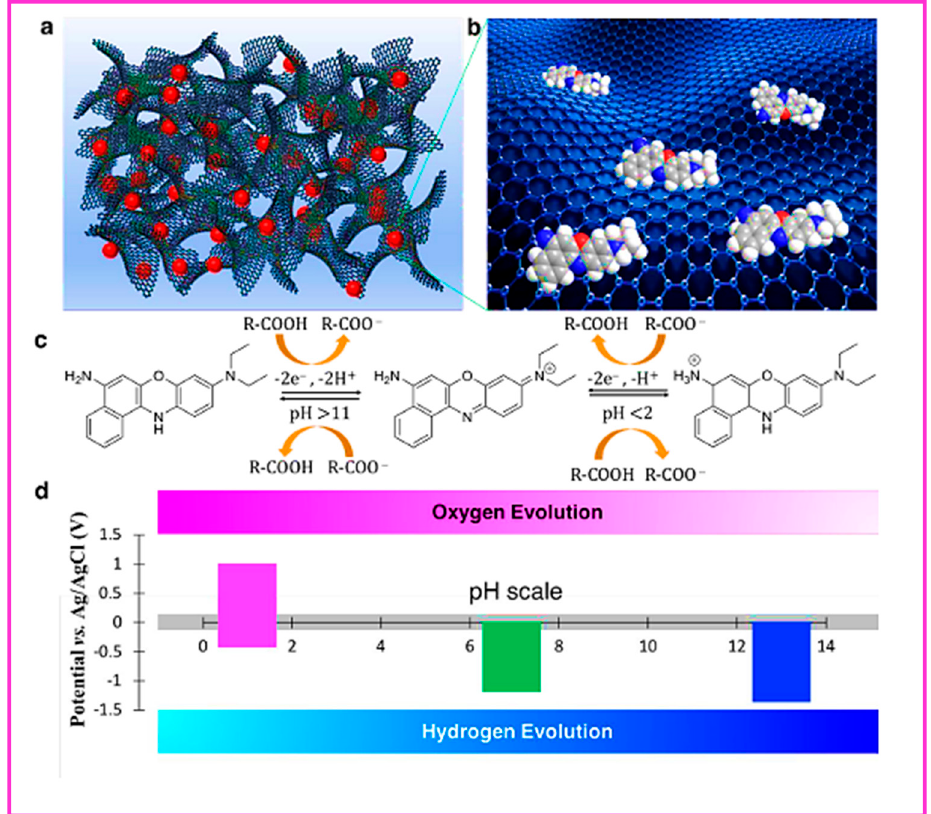
Figure 10. Illustration of the physically-chemically conjugation of Nile Blue. ( a ) The 3D porous structure of graphene aerogel ( b ), The possible faradic reactions of Nile Blue in strongly acidic and alkaline electrolyte, ( c ) The potential windows of the Nile Blue-conjugated graphene aerogel (NB-GA) composite-based electrodes in acidic, neutral, and alkaline media, ( d ) Potential windows of the NB-GA electrodes in acidic, neutral, and alkaline solutions. Reprinted with permission from [142], Copyright 2019, American Chemical Society.